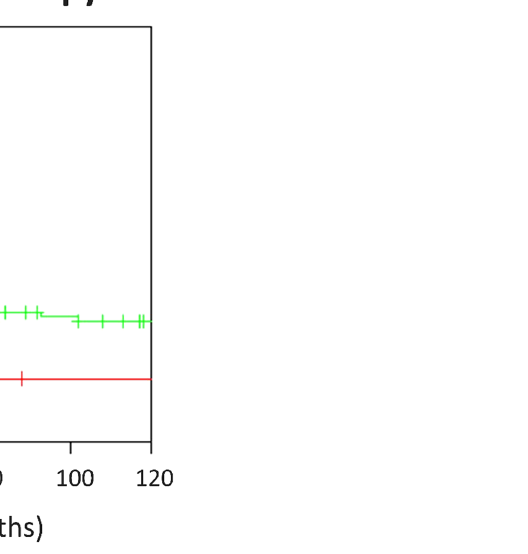
Figure 1. Kaplan-Meier survival curve for